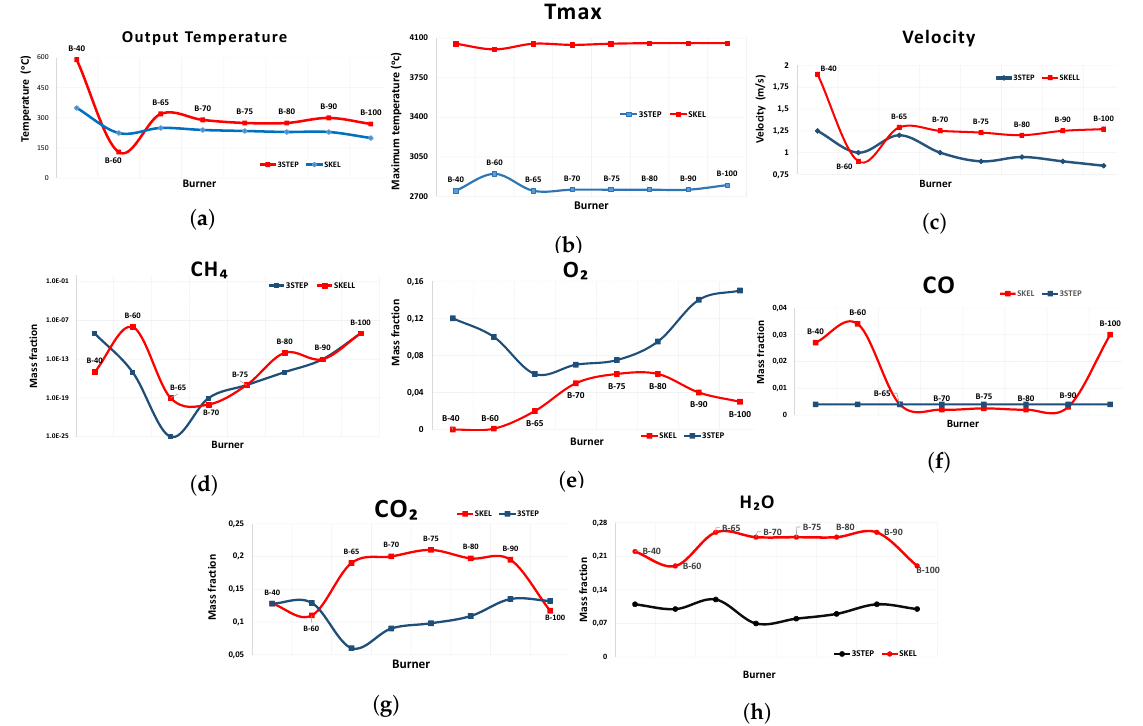
Figure 5. Comparison of skeletal and three-step mechanisms: ( a ) Output temperature, ( b ) maximum temperature, ( c ) velocity, ( d ) mass fraction of methane, ( e ) mass fraction oxygen, ( f ) mass fraction of carbon monoxide, ( g ) mass fraction of carbon dioxide, and ( h ) mass fraction of water vapor for the burners